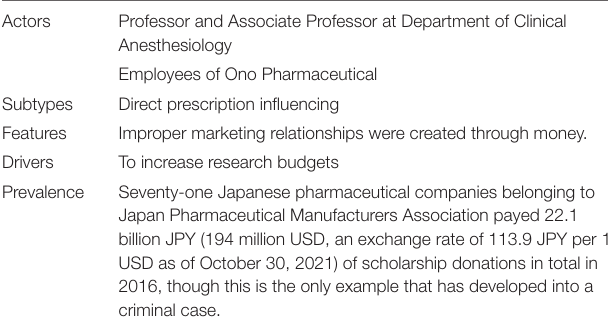
TABLE 1 | Improper marketing relations between Department of Clinical Anesthesiology, Mie University, and Ono Pharmaceutical through scholarship